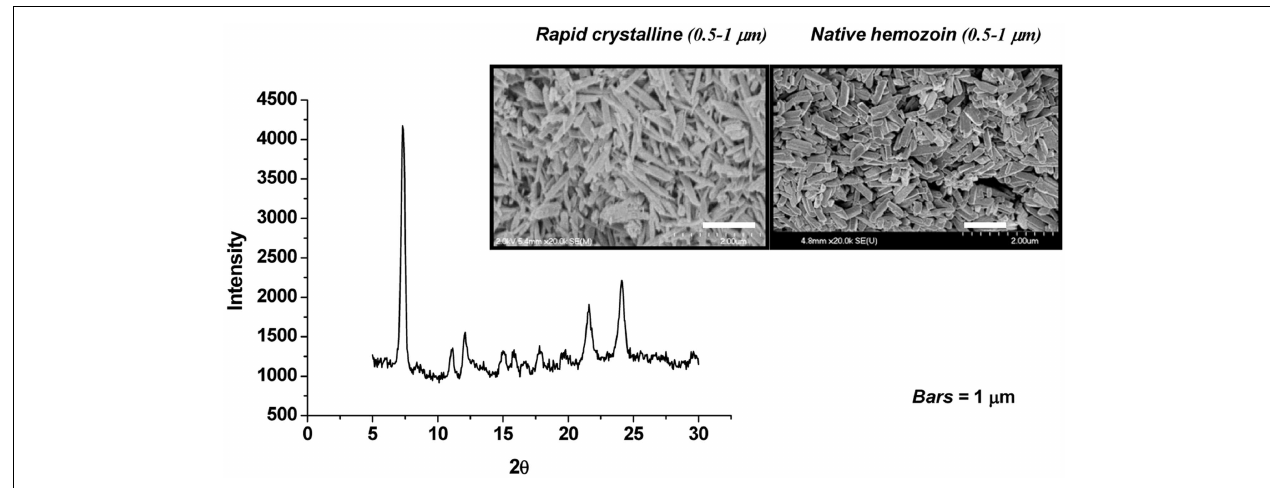
FIGURE 1 | Synthetic hemozoin analysis . Scanning electron micrographs of rapid crystalline HZ (rcHZ) and Plasmodium falciparum -native HZ. X-ray powder diffraction (XRD) analysis allows the determination of the quality of the crystal.Taken from Ref.